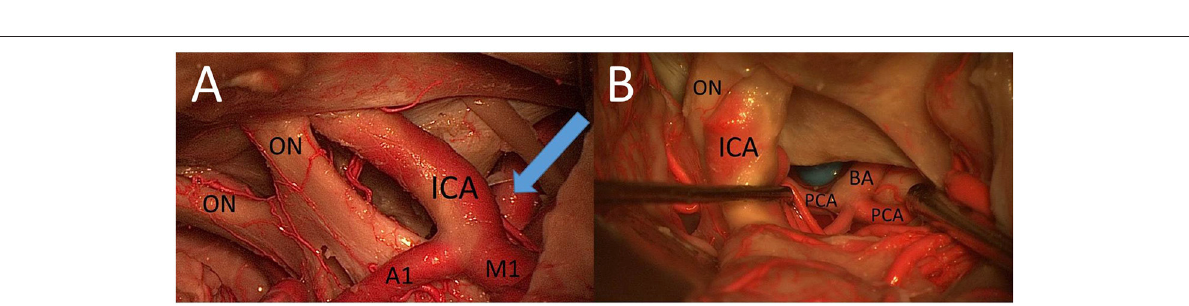
FIGURE 7 | The area under the optic chiasm: it is not possible to reach the area under the optic chiasm from the lateral aspect using the MSO approach (A) ; the area under the optic chiasm with the undersurface of the chiasm is easily visualized from lateral perspective through the opticocarotid window using the PT approach (B,C) (ON, optic nerve).